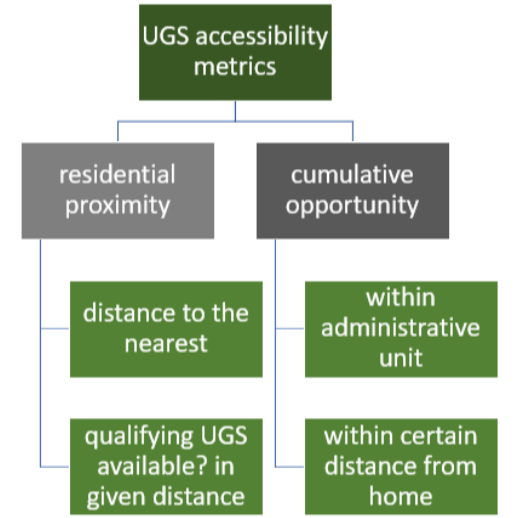
Figure 3. Categorization of UGS accessibility metrics (based on Ekkel and de Vries